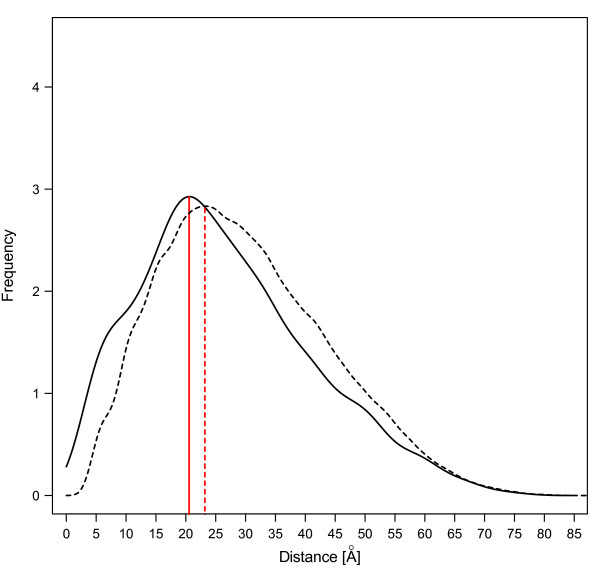
The 3D distance distribution of the coevolving residue pairs compared to all residue pairs in Rubisco. This is the minimum distance of the pair-wise residues between the active state and un-active state of Rubisco (based on the Spinacia oleracea structure 8RUC). Solid line is the distribution of pair-wise distances for coevolving residues. Dash line is the distribution of pair-wise distances for all protein residues.